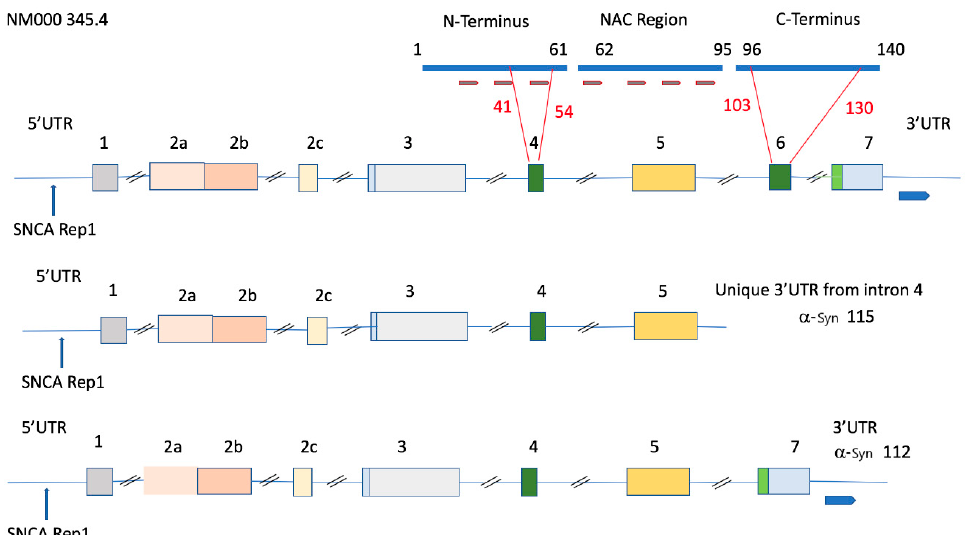
Figure 1. The main synuclein alpha (SNCA) transcript together with the shorter 115 and 112 variants associated with alpha-synuclein ( α -Syn) protein aggregation. The NCBI accession number NM000345.4 is on the left. Exons are numbered with alternative 5’ untranslated region (5’UTR) exons (2a–c) and are colored light pink. The REP1 repeat sequence is located on the 5’UTR. The thick blue line (top) represents the full-length 140-amino acid protein derived from codifying exons 3–7. The short brown bars represent the seven imperfect KTKEGV repeats associated with tetramerization and protein aggregation. Transcripts lacking exon 6 lack the C-terminus, which prevents aggregation by masking these repeats. Exons 4 and 6 (dark green) are alternatively spliced exons giving rise to SNCA 112 (lacking exon 6), SNCA 126 (lacking exon 4) and SNCA 98 (lacking both exon 4 and 6) (not shown). Light blue indicates non-translated parts of exons 3 and 7, and light green indicates the corresponding SNCA-translated sequence. The SNCA 115 transcript associated with alcohol use disorder (AUD) encodes a 115-amino acid polypeptide coded from exons 3–5, whose transcript has a unique 3’UTR containing the first 393 nucleotides of intron 4.